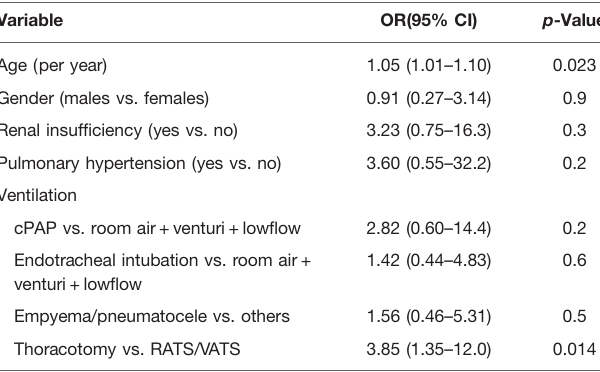
TABLE 6B | Multivariable logistic regression model on morbidity concerning postoperative complications ( n =83, 34